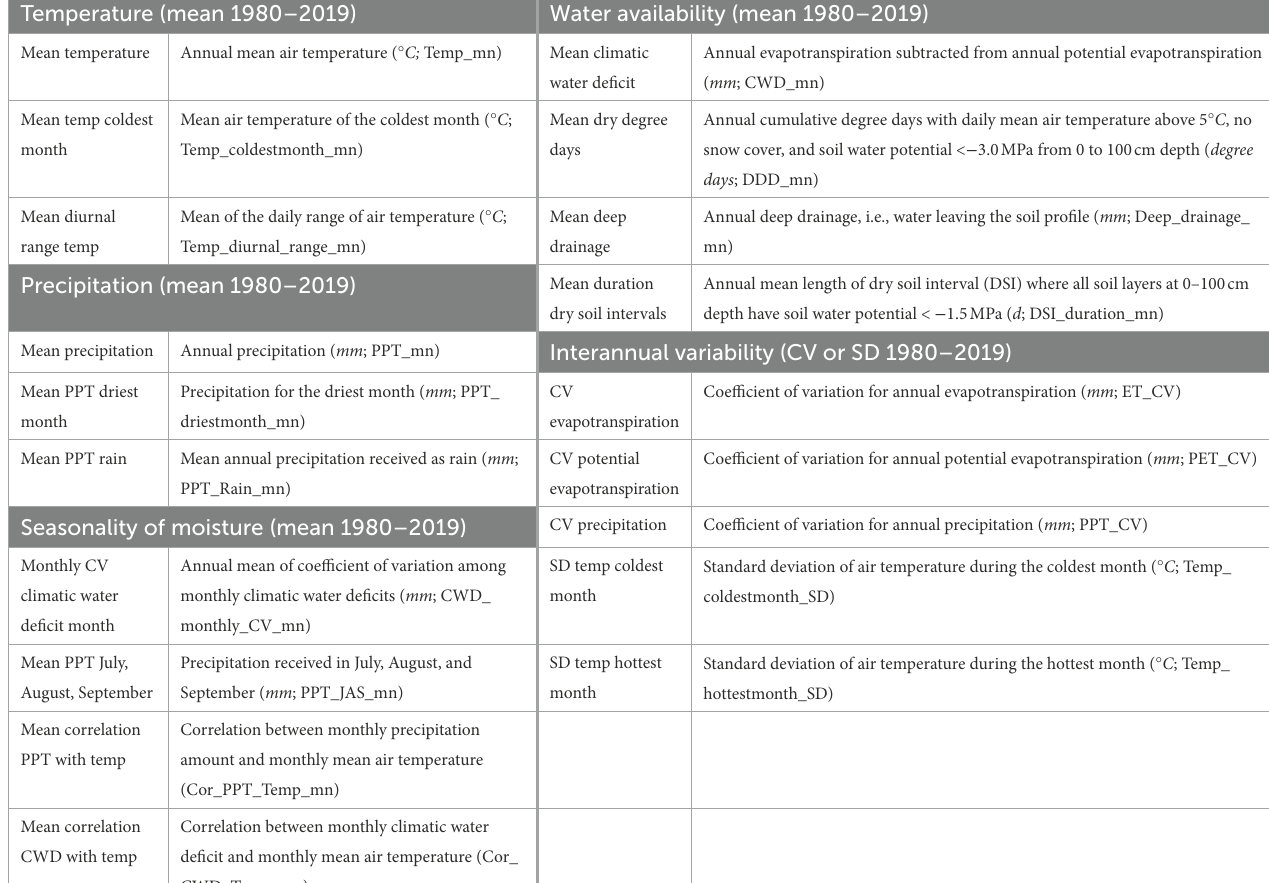
TABLE 1 Variables used in the